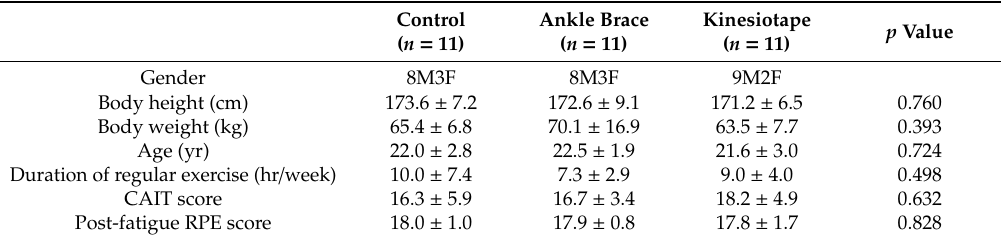
Table 1. Anthropometric data (Mean ± standard deviation) and functional ankle instability evaluation scores.